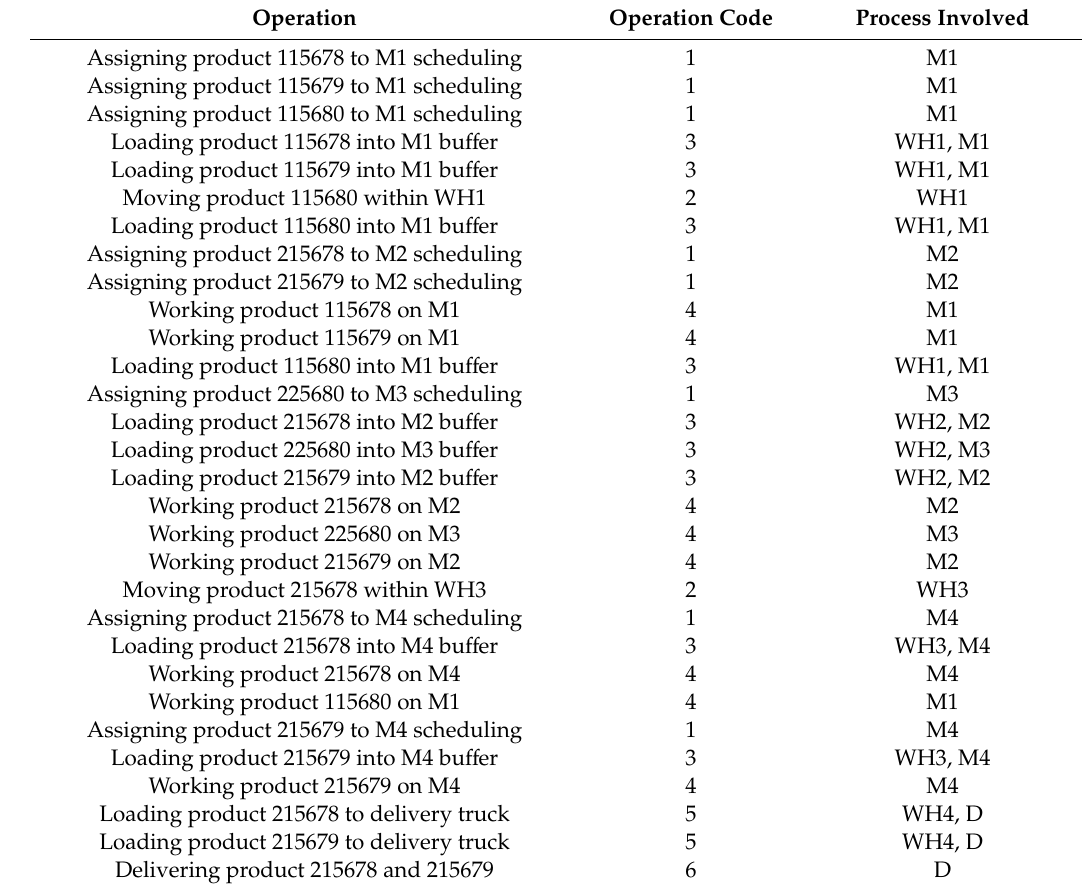
Table 6. Production operations in case of machine